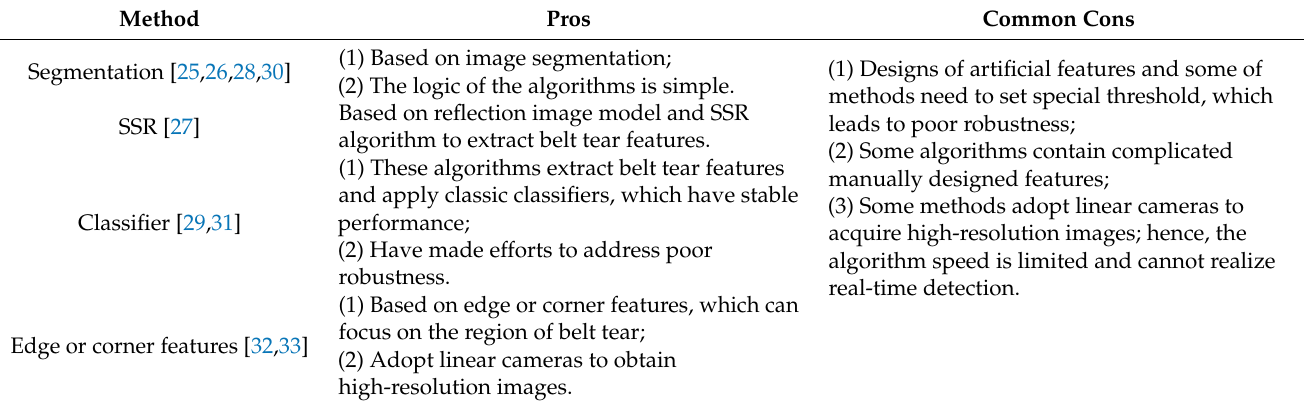
Table 3. Comparison of machine vision